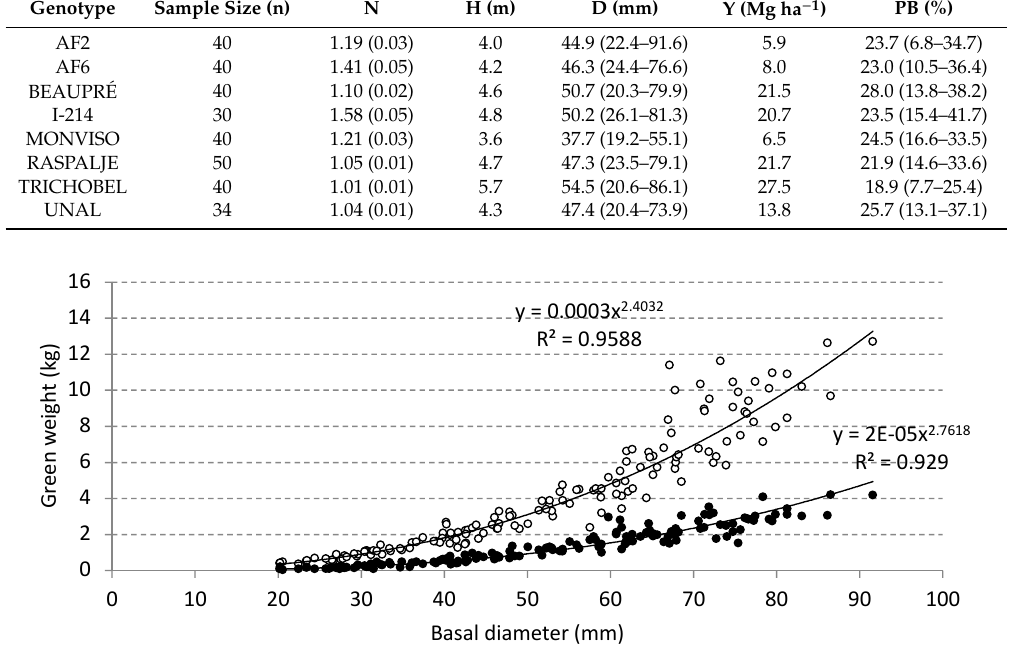
Figure 1. Green weight of the stem (white dots) and the branches and twigs (black dots) of the samples. The equations show the allometric fit of the green weight, considering the basal diameter (d, mm) as an explanatory variable.